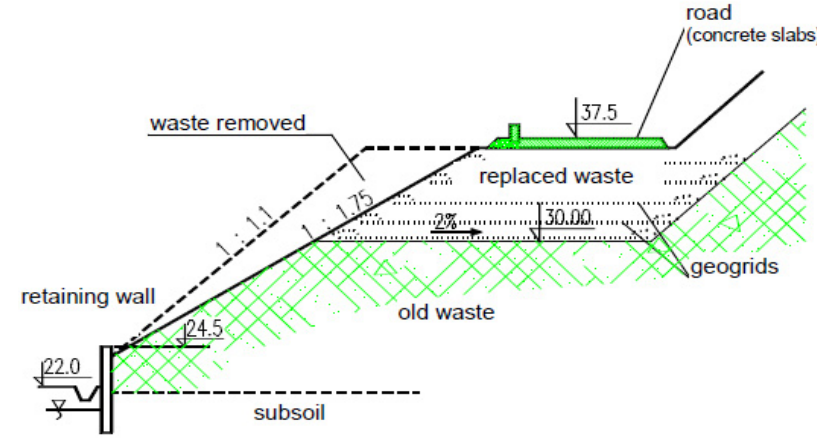
Figure 2. The process of geogrid installation in the landfill (1993).